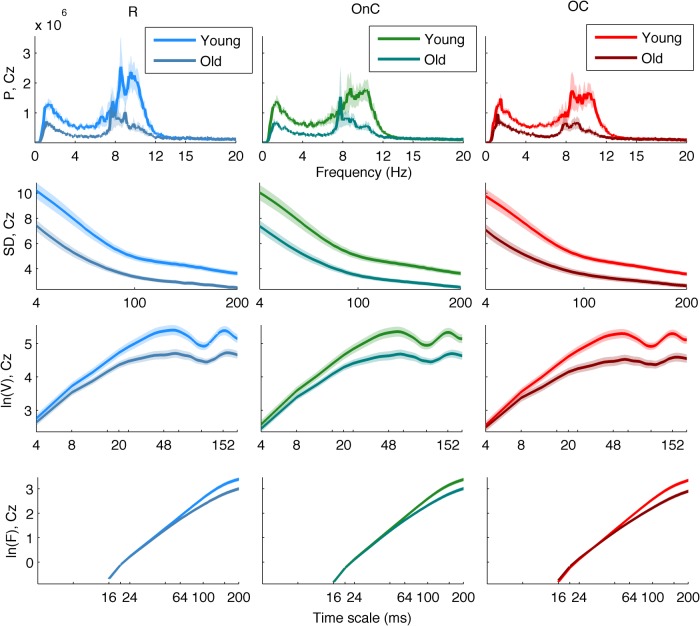
Group means and SE intervals of the metrics of the variability magnitude across conditions. From top to bottom: P, ln(V), SD, and ln(F) are shown for channel Cz, for all conditions (R, bluish colors; OnC, greenish colors; OC, reddish colors, from left to right columns), with darker colors for old participants (lighter for young). Thick lines and areas of faded colors represent the means and the SE intervals, respectively. Horizontal axes depict frequency for P, and time scale logarithmically for ln(F) and ln(V), and linearly for SD. Please note the group differences, which are similar (but not identical) among conditions. The magnitude of variability is generally higher for young participants than old participants across scales, particularly so for longer time scales and lower frequencies (except for a small interval ∼8 Hz).